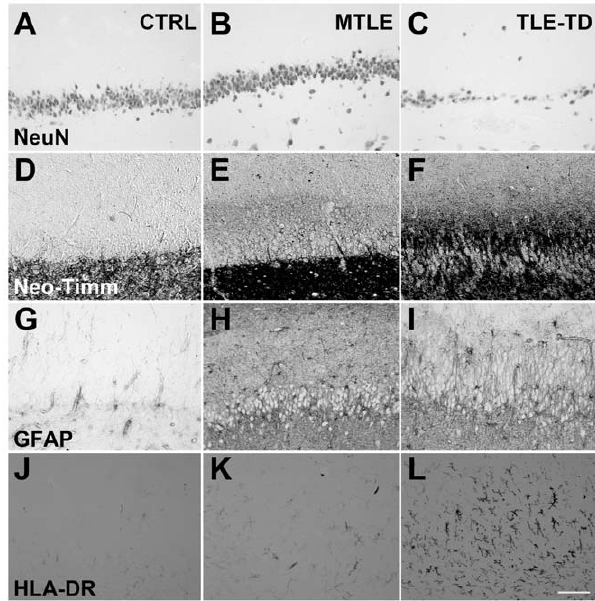
Figure 2. Representative images of NeuN, neo-Timm, GFAP and HLA-DR staining in the Fasciadentata of Ctrl, TLE-TD and MTLE patients. The pattern of NeuN staining is the same in Ctrl (A), TLE-TD (B) and MTLE (C) groups, but MTLE shows reduced neuronal population in this subfield. Compared to Ctrl (D), increased neo-Timm staining was observed in the inner molecular layer of fascia dentata in MTLE patients (F), but not in TLE-TD (E). As for the astroglial population, both hyperplasia and hypertrophy are observed in MTLE (I) and TLE-TD (H), compared to Ctrl (G). Hyperplasia is also observed in microglial cells in TLE-TD (K) and, more notable, in MTLE (L), compared to Ctrl (J). Bar in L indicates 100 micrometers.